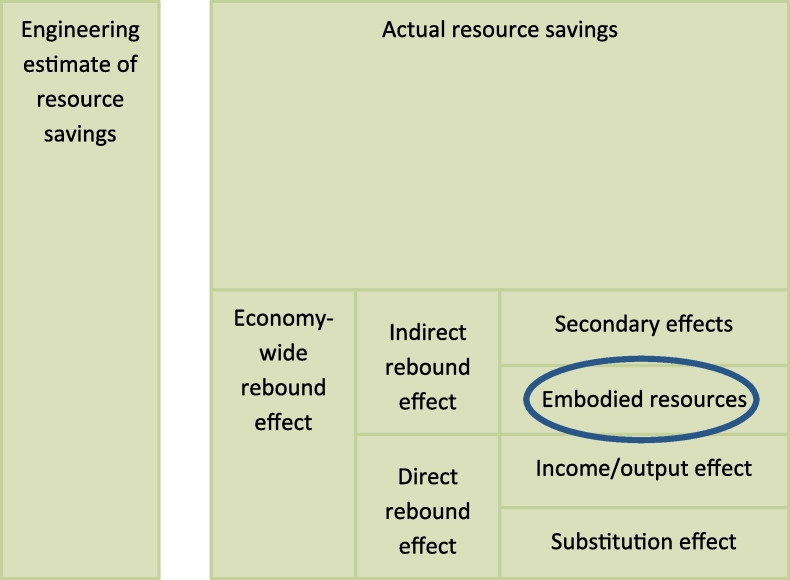
Types of rebound effects (Based on Sorrell (2007)).